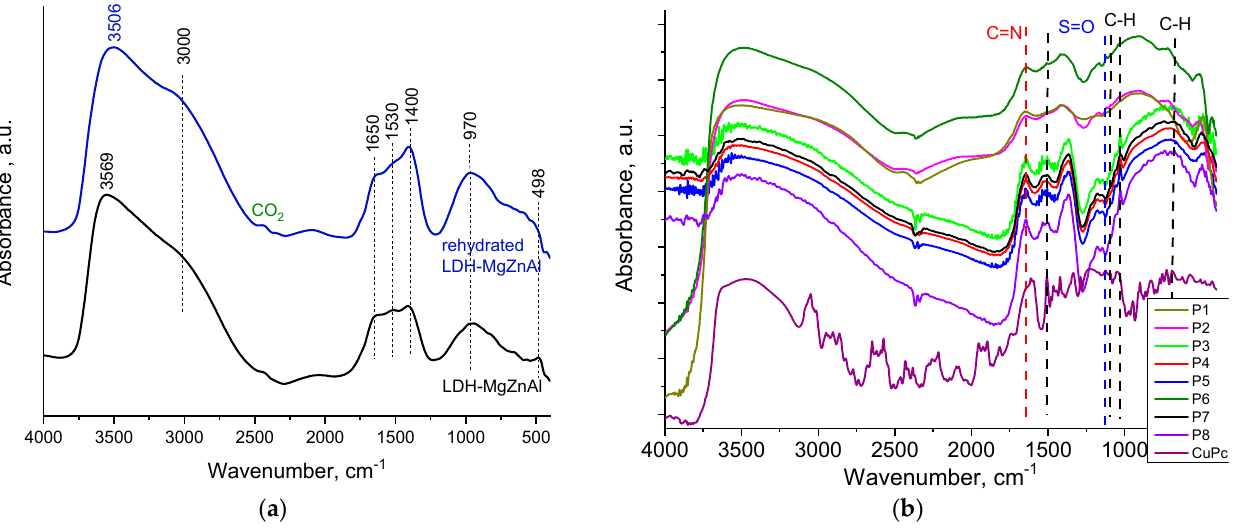
Table 3. Surface area, pore volume, and main pore size for LDH, rehydrated LDH, and P1–P8 cat- alysts.